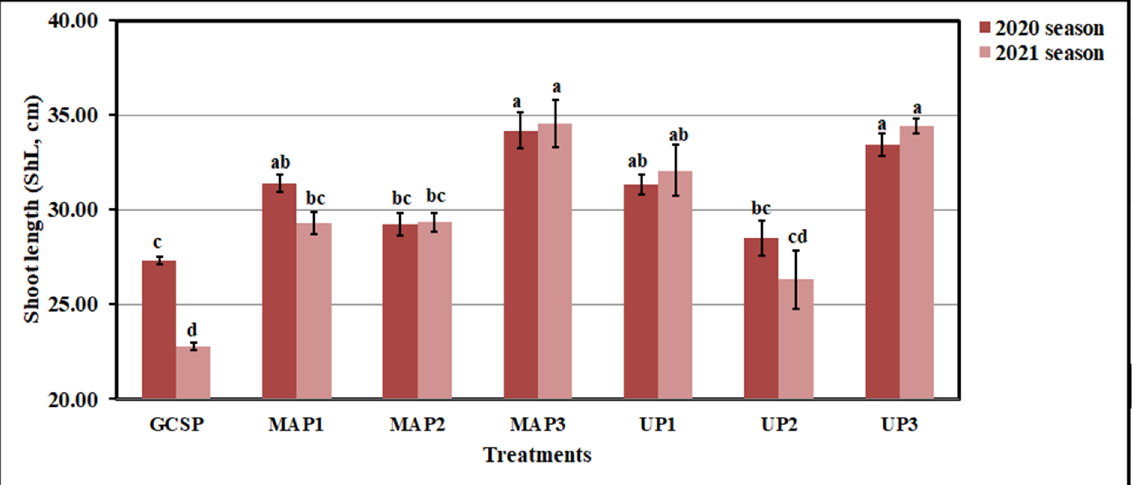
Figure 1. Influence of two phosphorus fertilizers; mono-ammonium phosphate (MAP) and urea-phosphate (UP) in comparison with granular calcium phosphate (GCSP) applied to shoot length (ShL, cm) of olive (arbequina cv.) trees grown in sandy loam clay soil under multi-abiotic stresses (CaCO 3 = 8.8 vs. 9.2%, ECe = 6.4 vs. 7.2 dS m − 1 , and pH = 7.78 vs. 7.89) during 2020 and 2021 seasons. GSCP applied represents 1.75 kg tree − 1 , MAP 1 , MAP 2 , and MAP 3 represent MAP applied at 0.336, 0.445, and 0.555 kg tree − 1 , and UP 1 , UP 2 , and UP 3 represent UP applied at 0.465, 0.616, and 0.770 kg tree − 1 . Bars in the same years with a different letter indicate significant differences between treatments at p ≤ 0.01. According to Duncan’s multiple range test, bars sharing the same letter in each column are not signi fi cantly different .